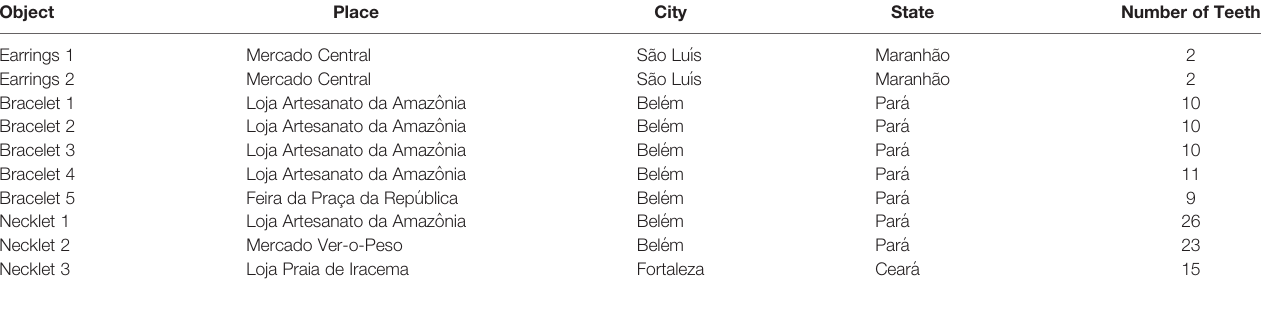
TABLE 1 | Handicrafts collected in three major cities from the Brazil Northern and Northeastern regions. Object Place